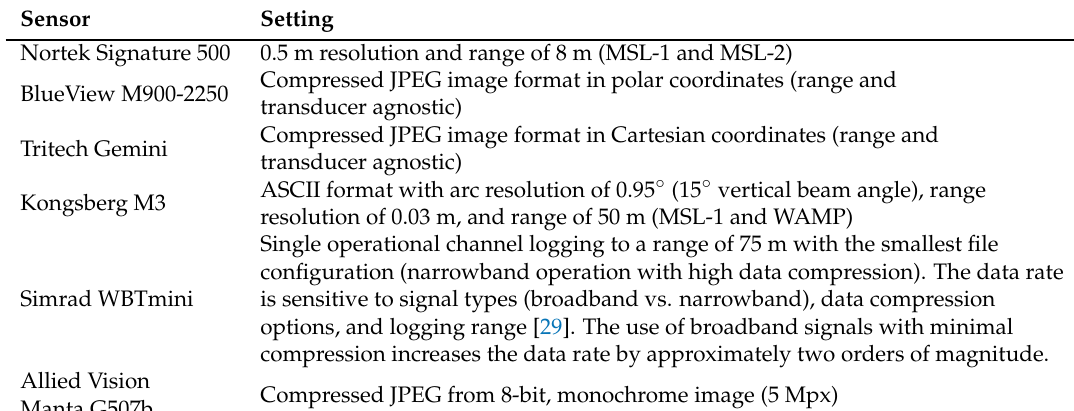
Table A2. Sensor configurations for data rates shown in Table